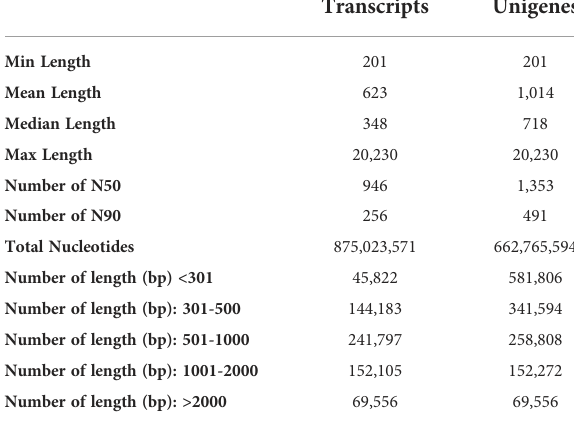
TABLE 1 A Summary of assembled transcripts and unigenes for all